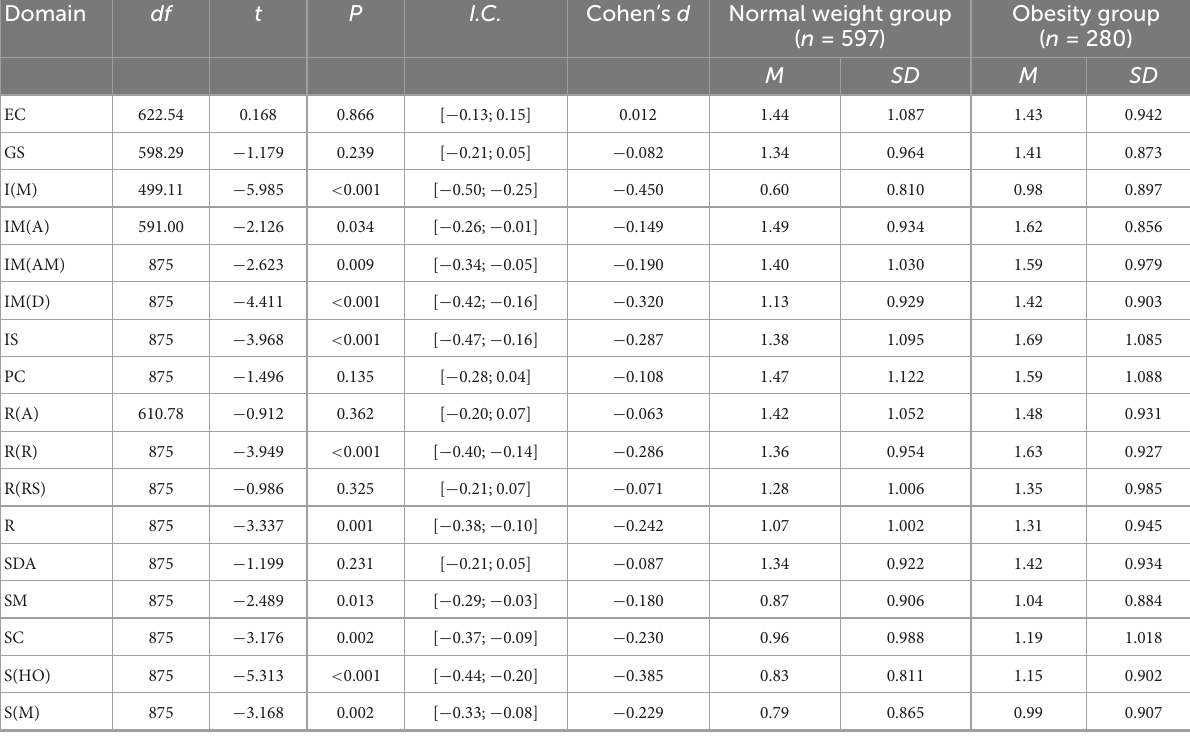
TABLE 6 Criterion validity (normal group vs. clinical group) of OxFAB-MAW, through an independent T